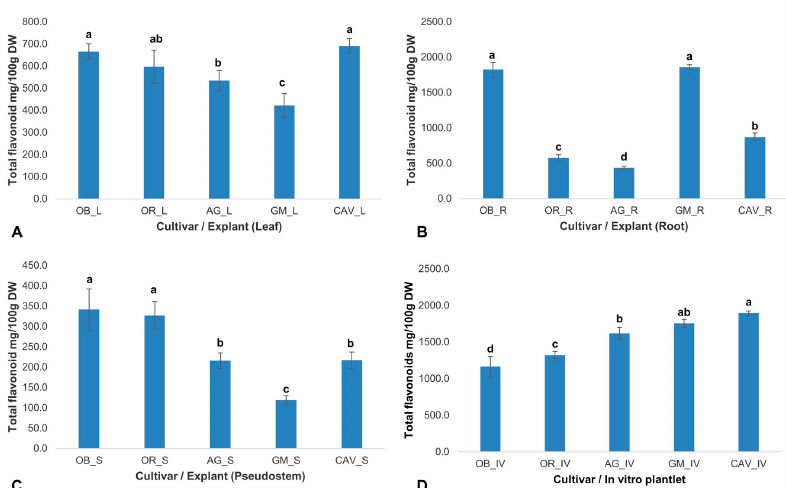
Figure 3. Total flavonoids in explants of field-grown plants and in vitro plantlets of di ff erent cultivars of banana and plantain. ( A ) Leaf (L) explant; ( B ) Root (R) explant; ( C ) Pseudostem (S) explant; ( D ) In vitro (IV) plantlet. Each bar represents the mean of triplicate samples ( n ≥ 3), and the error line indicates the standard deviation. Means with di ff erent letters (a—d) are significantly di ff erent from each other at p ≤ 0.001 (highly significant). OB—Obino l’Ewai; OR—Orishele; AG—Agbagba; GM—Gonja Manjaya; CAV—Cavendish Williams; DW—Dry weight of sample.